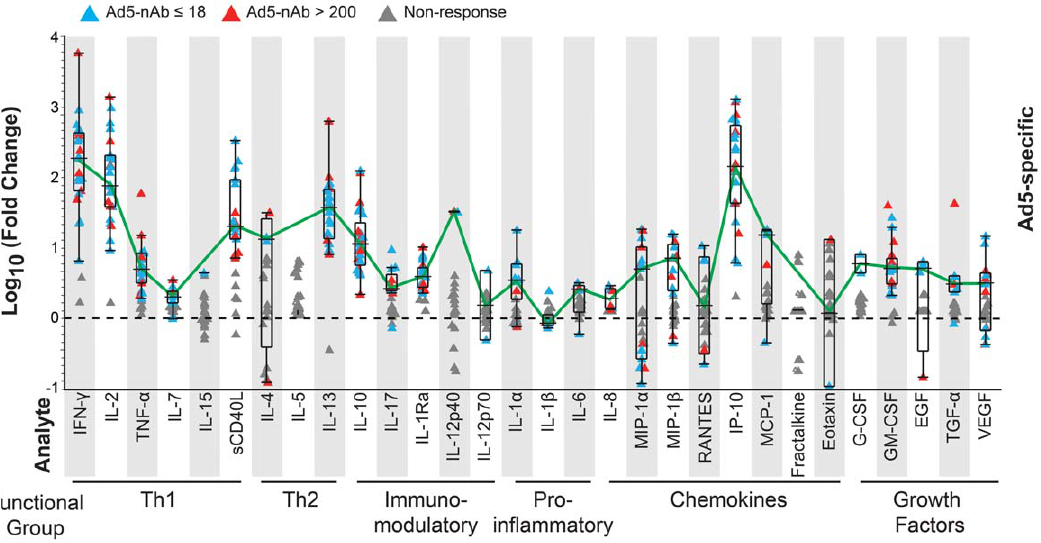
Figure 3. Frequency and magnitude of Ad5-stimulated cellular responses of vaccinees prior to vaccination. PBMC collected from trial participants prior to vaccination (baseline) were tested by multiplex cytokine assay. Magnitudes of response for 30 analytes tested are expressed as log 10 fold change over background for Ad5-seronegative (n=17, blue triangle) and Ad5-seropositive (n=8, red triangle) volunteers. Non-responders are shown in gray. Box and whisker plots indicate median and interquartile ranges for responders only, while connecting line illustrates overall profile for comparison.